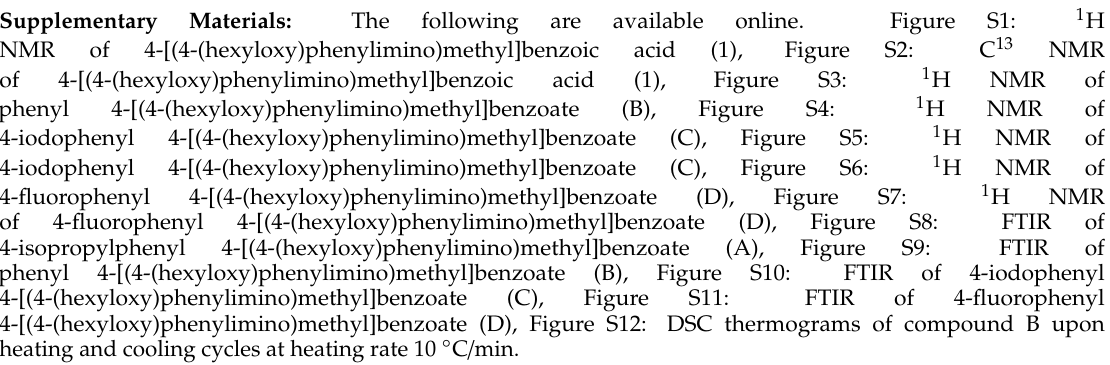
4-[(4-(hexyloxy)phenylimino)methyl]benzoate (D), Figure S12: DSC thermograms of compound B